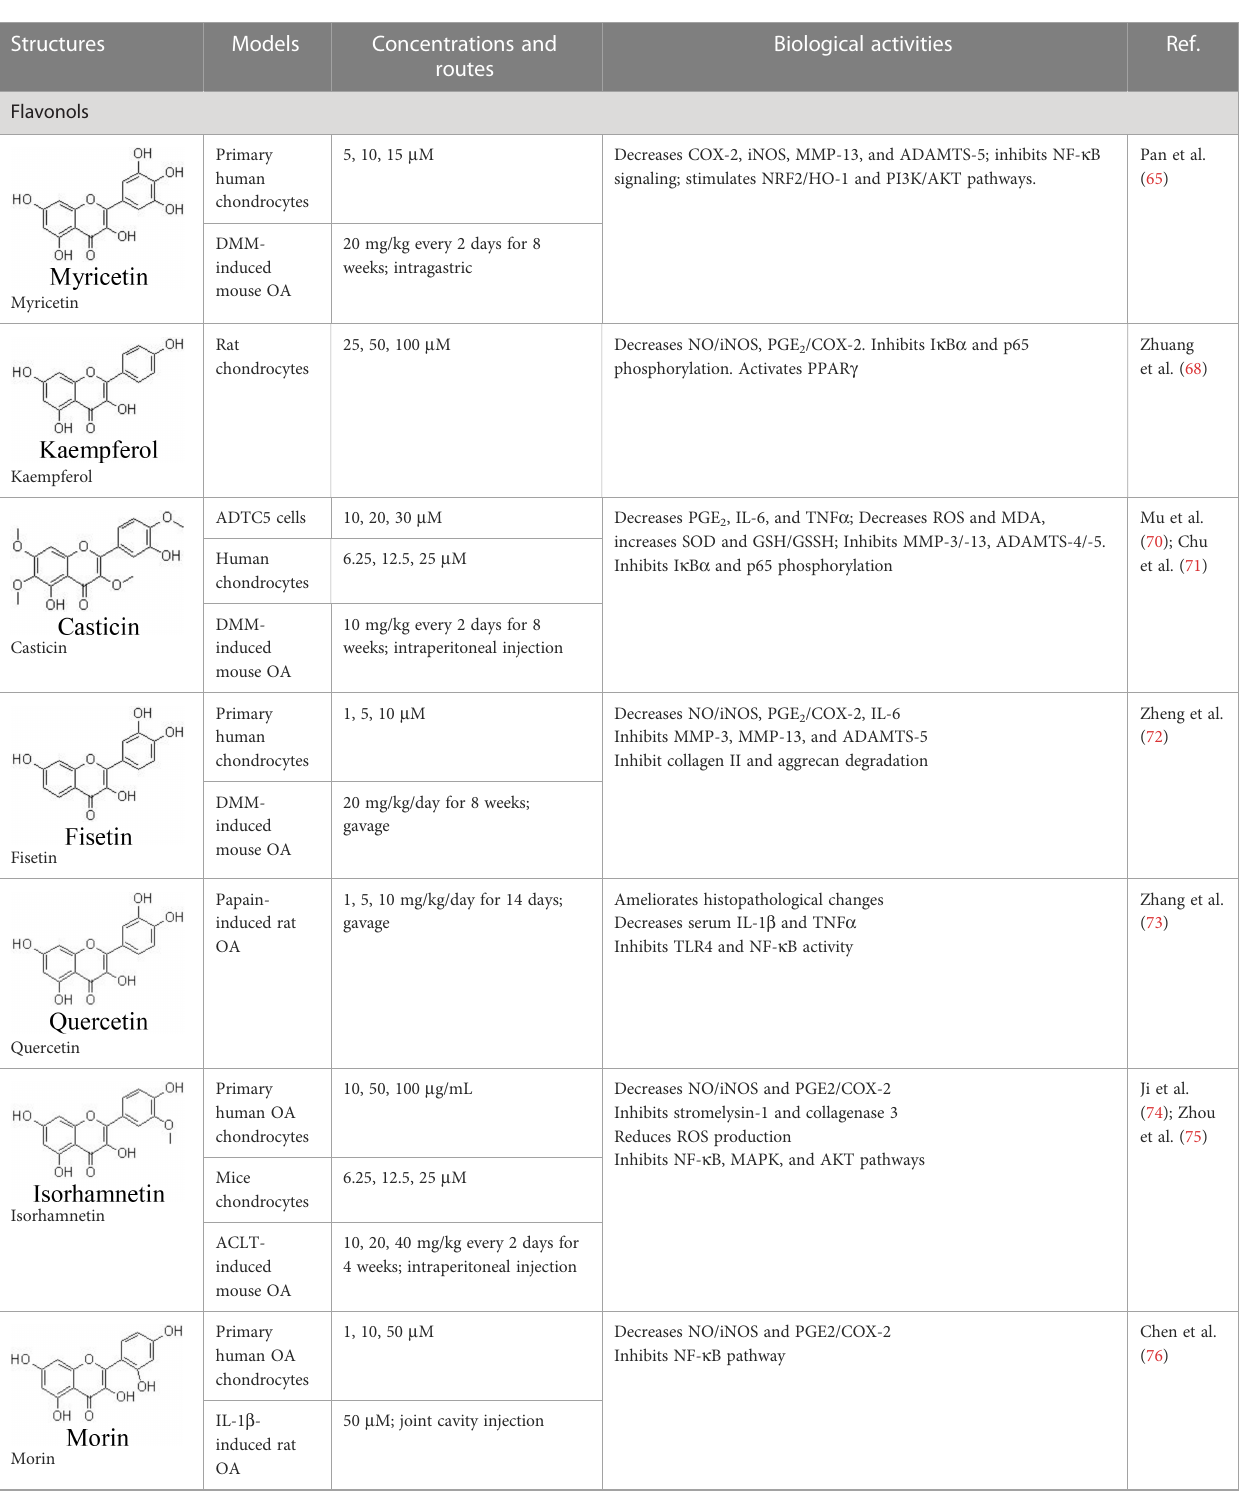
TABLE 1 Various fl avonoids show protective activity against OA.